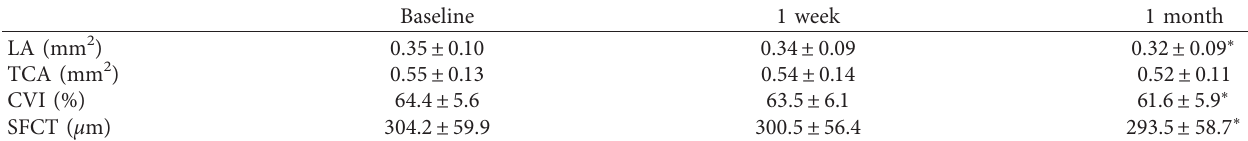
Table 2: Changes of choroidal parameters in eyes with refractory DME after switching to PSTA treatment.